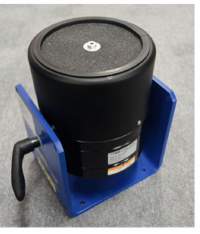
Figure 4. Adopted shaker in the basic investigation.